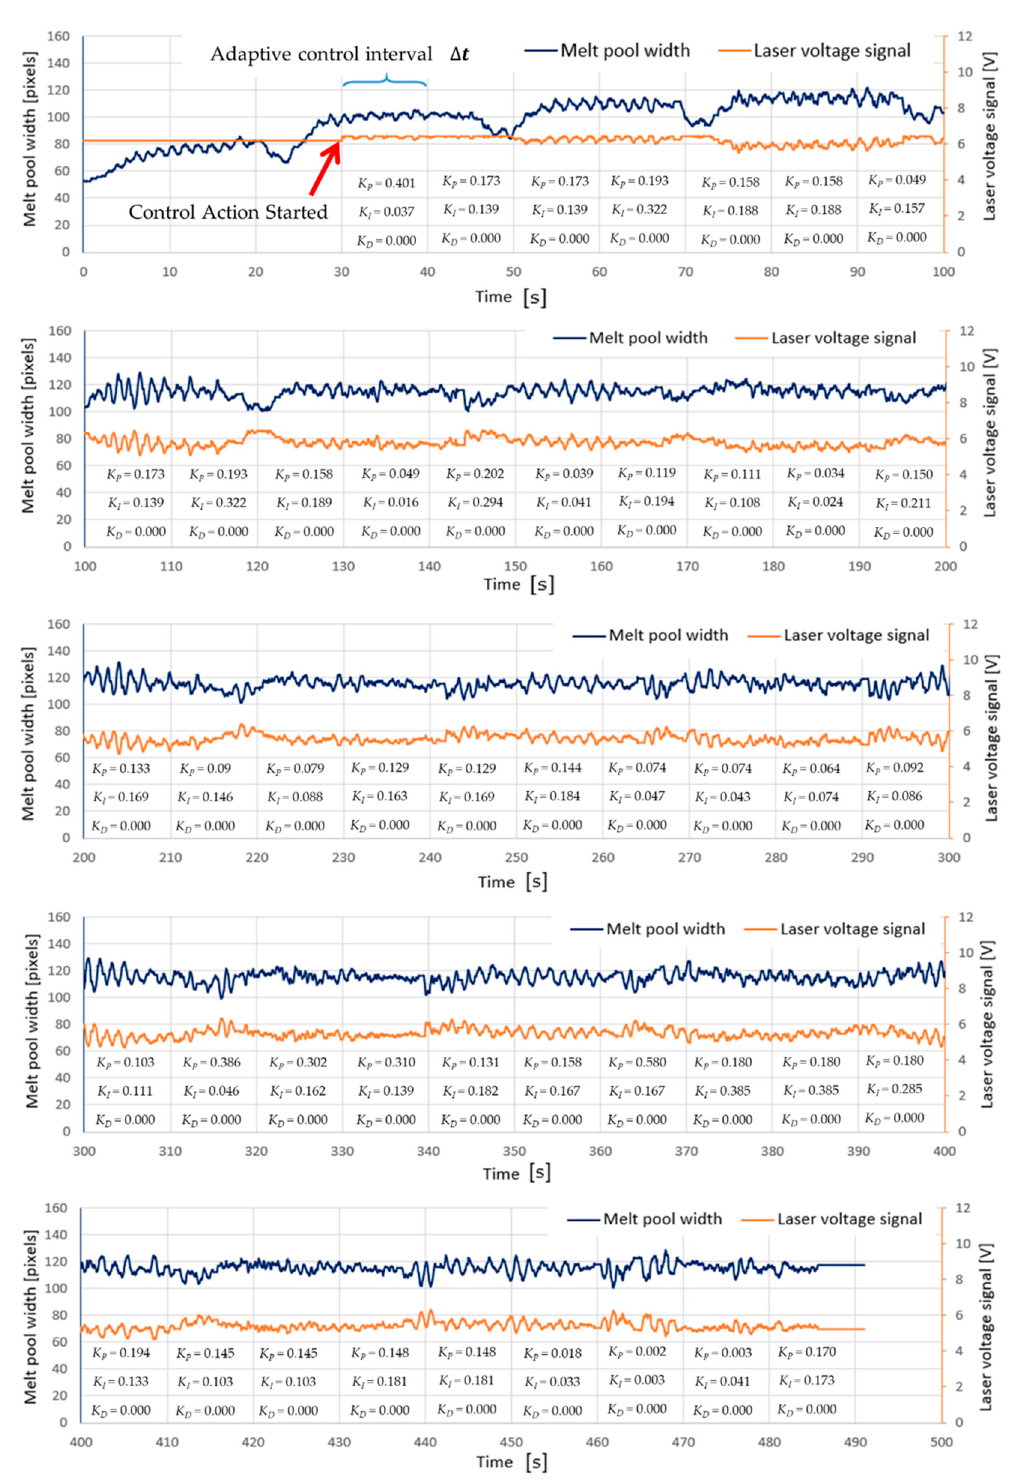
Figure 7. The MPW data for the entire time-domain extracted from Figure 6c, showing the automatic update of the controller parameters ( K P , K I , K D